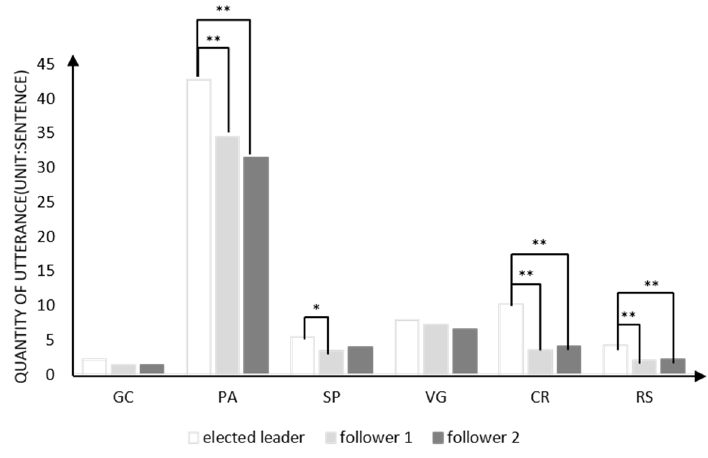
Figure 3. Problem-solving performance of elected leader and followers in group creativity. Note: *: p < 0.05, **: p < 0.001.